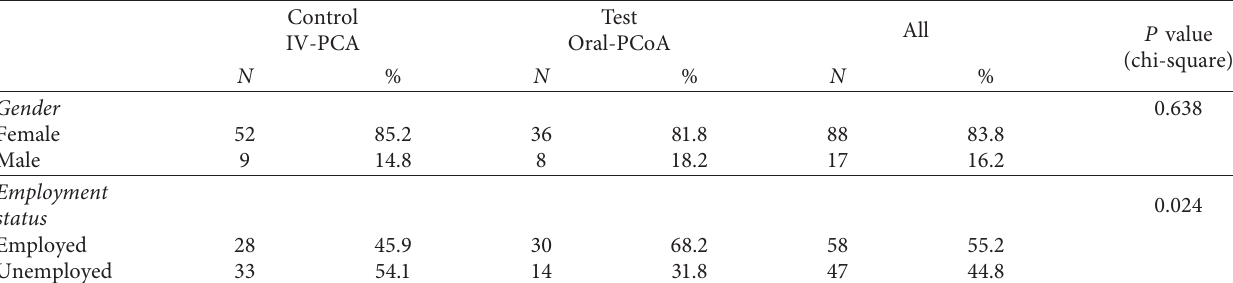
Table 3: Cross-cohort comparison of baseline categorical variables by chi-square for independent